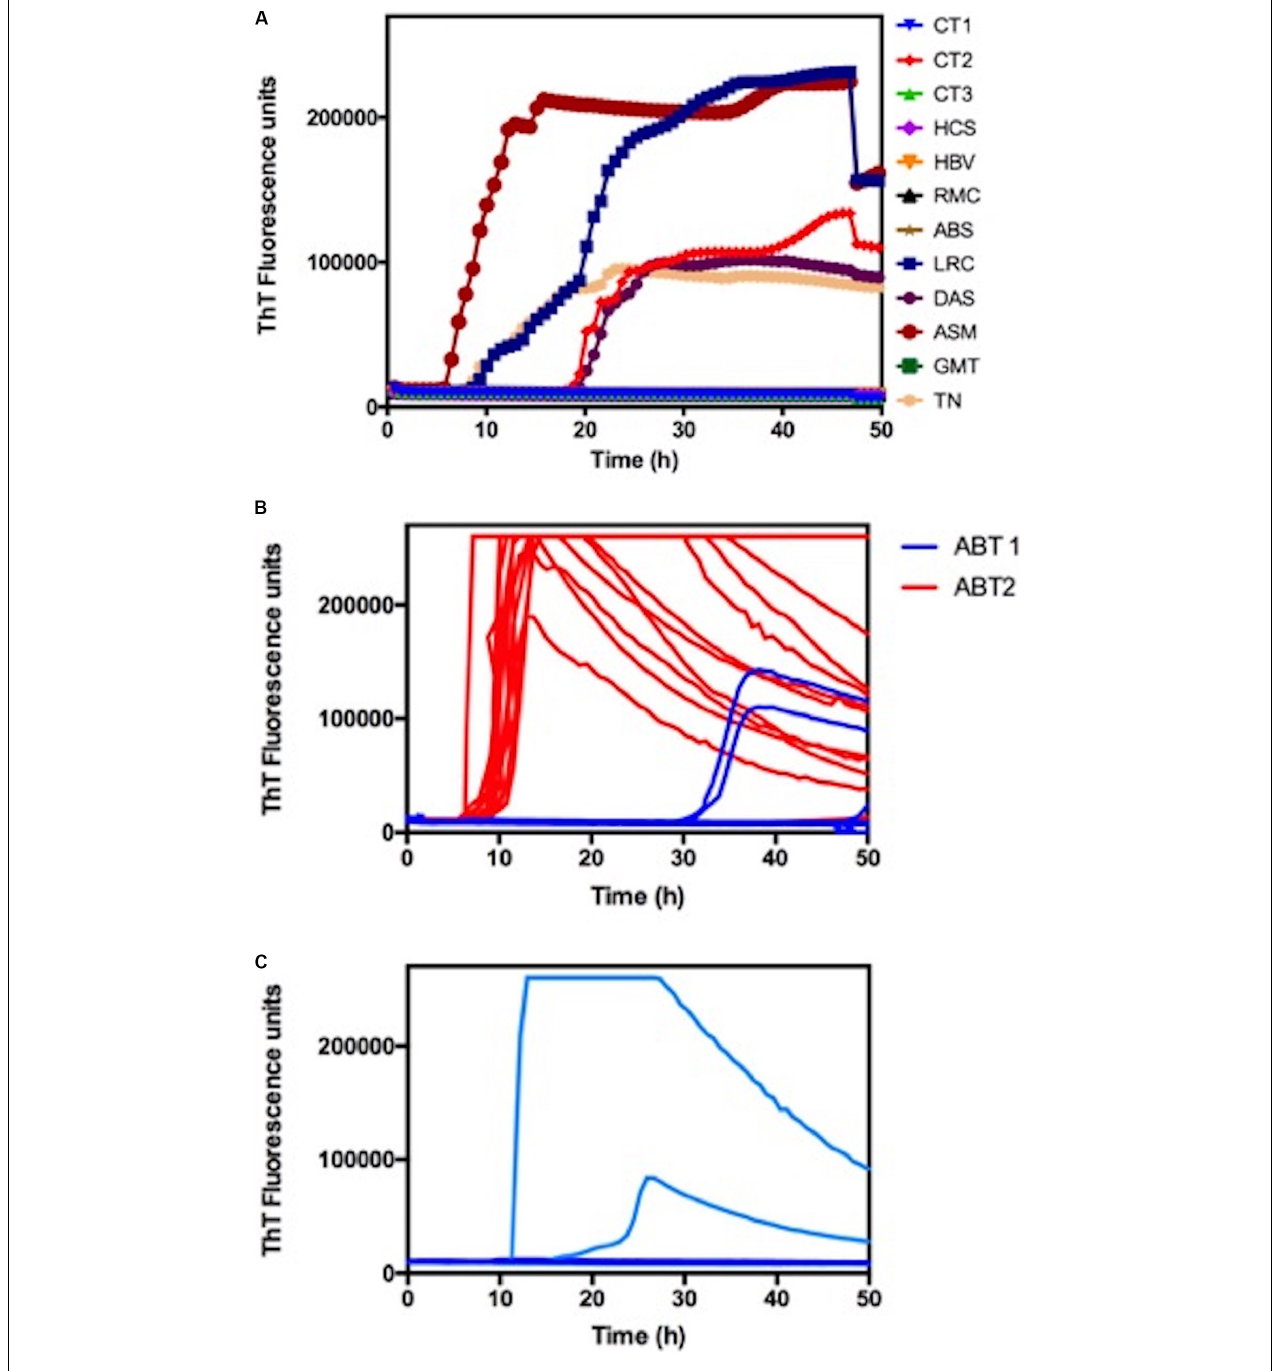
FIGURE 2 | Blind RT-QuIC analysis of CSF samples. (A) RT-QuIC responses from reactions seeded with 20 µ l of CSF from suspected CJD cases (LRC; DAS; ASM; JJN; GMT, TN). The RT-QuIC responses from reactions seeded with CSF samples from patients with other neurological disorders (CT1; CT2; CT3; HCS; HBV; RMC; ABS) were used as a negative control. Each curve represents the mean of four replicate readings of three or four repetitions. (B) Single-well analysis of CSF samples from patient ABT. ABT1 and ABT2 refer to the first and second collections, respectively. (C) Single-well analysis of CSF samples from patient